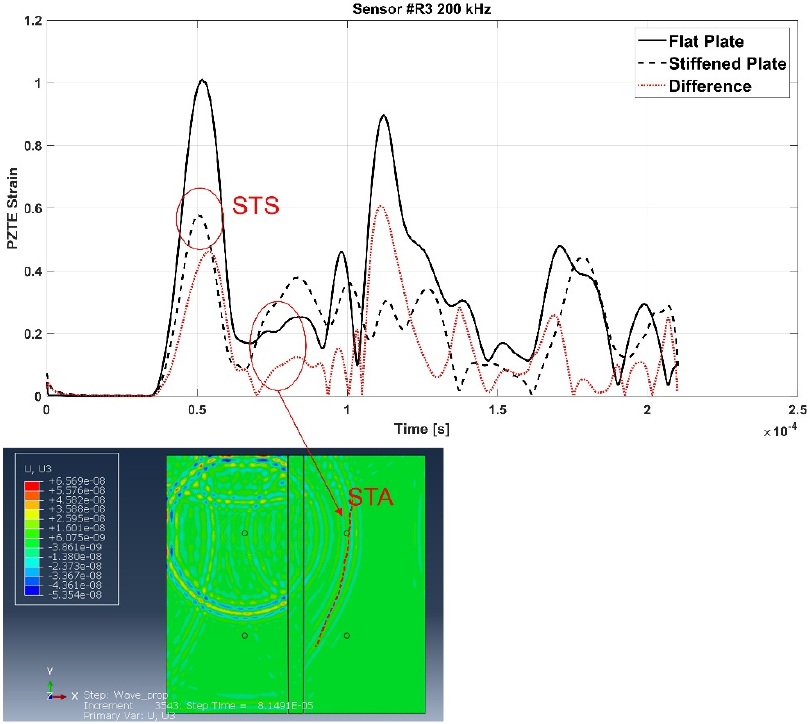
Figure 10. STA mode at 200 kHz carrier detected by the R3 sensor – aluminum stiffened plate.